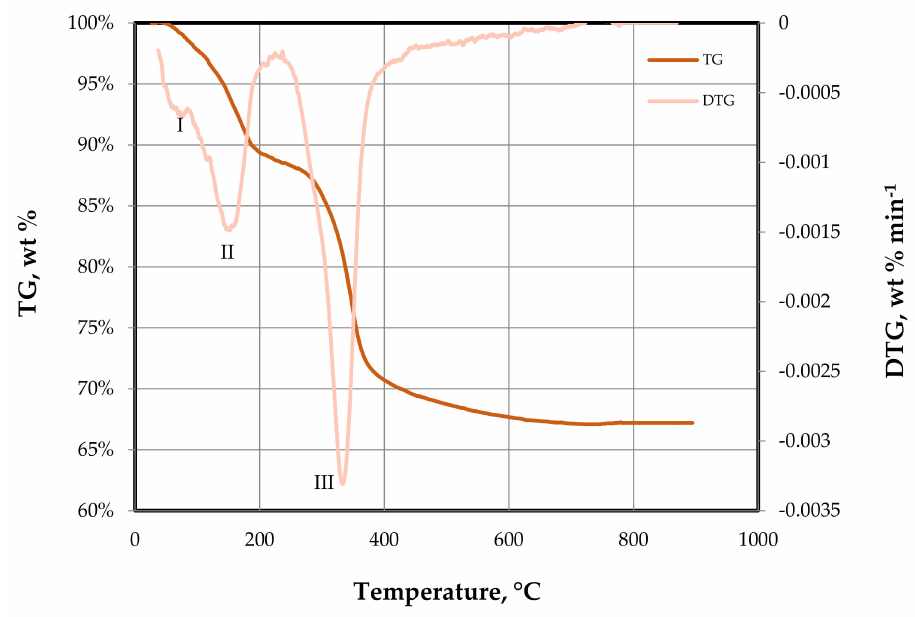
Figure 2. Thermogravimetric analysis (TGA) and differential thermal analysis (DTG) from as-synthesized